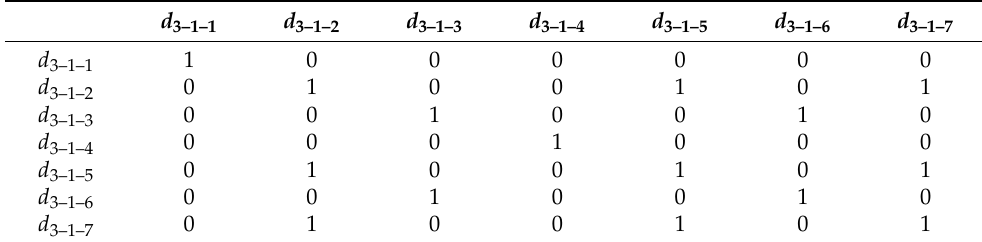
Table 7. λ -cut matrix of (cid:101) R (cid:48) of customer d 3–1 with λ = 0.93.